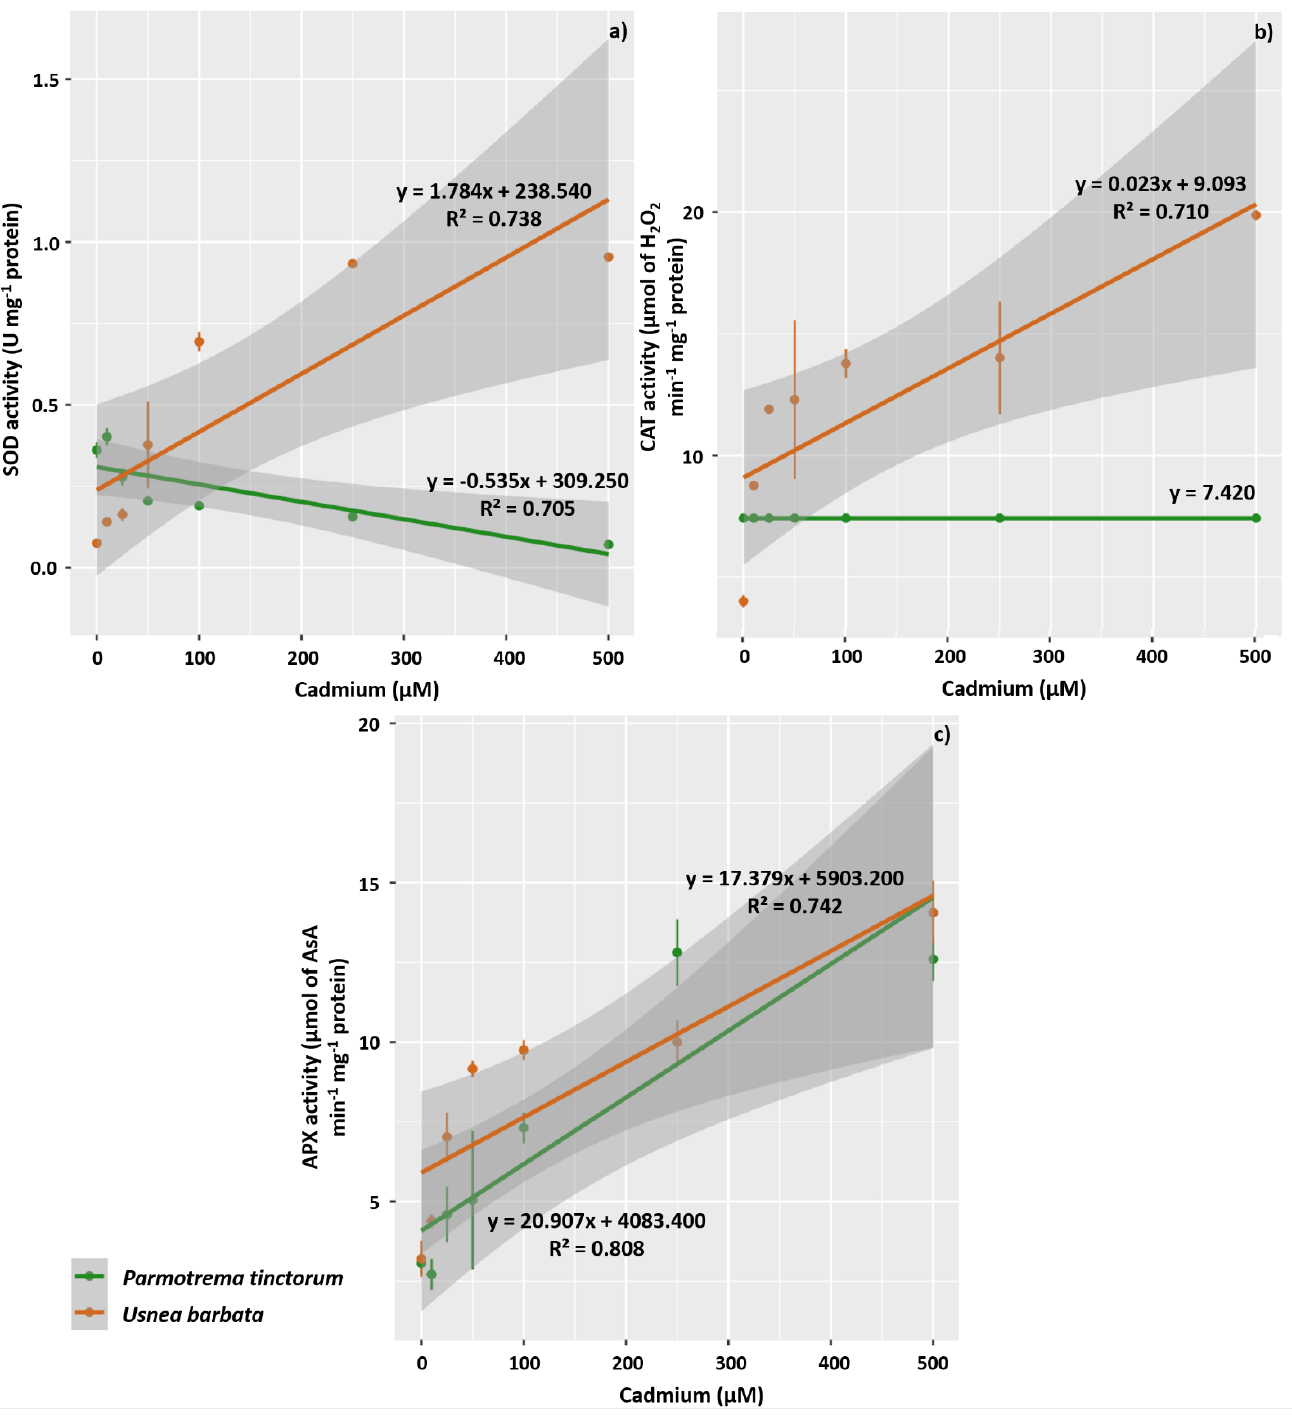
Figure 10. Activities of the enzymes superoxide dismutase (SOD) ( a ), catalase (CAT) ( b ), and ascorbate peroxidase (APX) ( c ) observed in the thalli of the lichen species Parmotrema tinctorum and Usnea barbata subjected to different concentrations of Cd (0, 10, 25, 50, 100, 250, and 500 µM). The straight lines represent the fitted model, and the prediction intervals (95%) are gray.